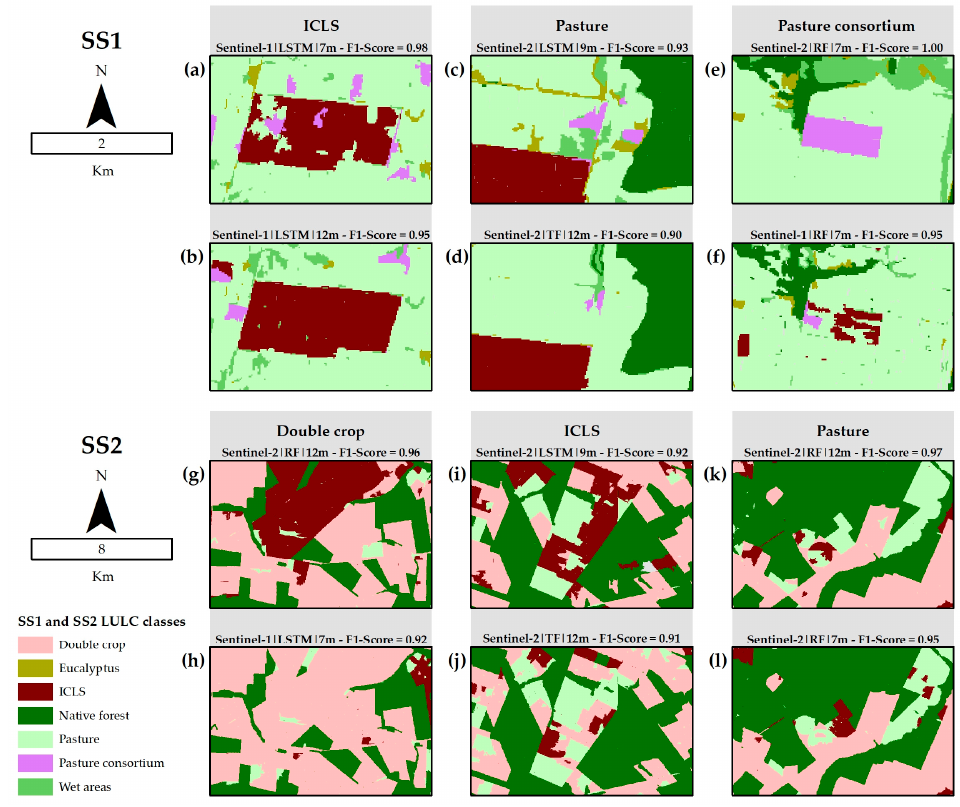
Figure 5. Predictions for both study areas using different models and sensors with similar accu- racy